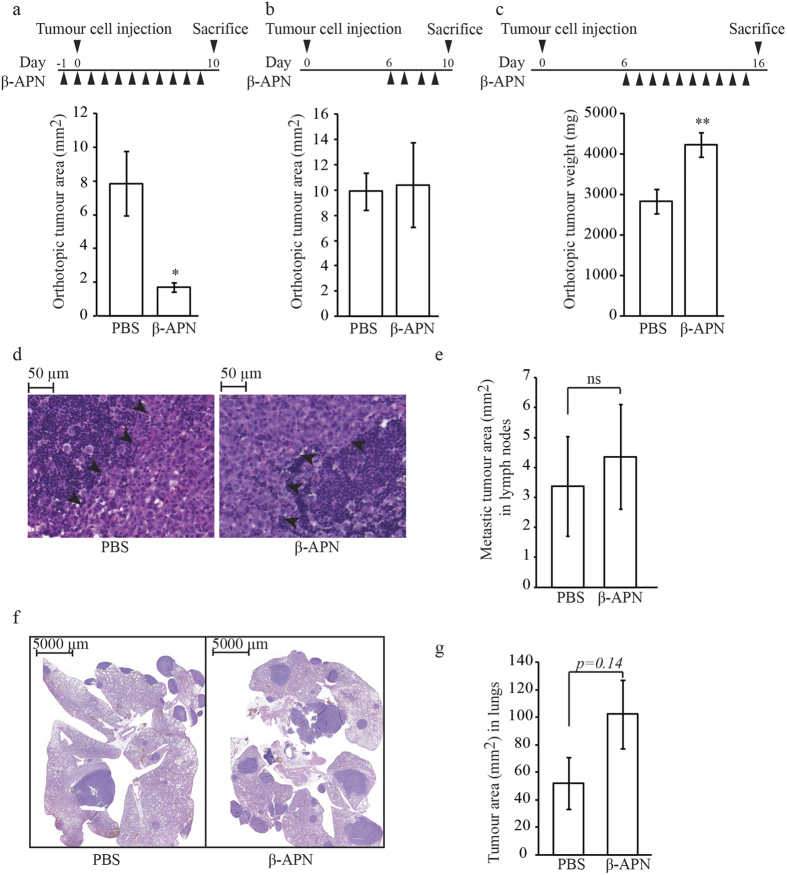
BAPN treatment of rat prostate tumours.Rats were injected orthotopically with AT-1 prostate tumour cells (2 × 103 cells) and treated with an inhibitor of LOX-family enzymes (BAPN, 100 mg/kg) or vehicle (PBS) and tumour weight was analyzed in three different experiments: (a) treatment was started one day before tumour cell implantation and continued on a daily basis until sacrifice at day 10; (b) treatment was started on day 6 when tumours were established, and continued on a daily basis until sacrifice at day 10; and (c) treatment started on day 6 and continued on a daily basis until sacrifice at day 16. Values are mean tumour area (mm2) or mean tumour weight (mg) at sacrifice ± SEM; n = 6–8 per group; *p < 0.05, **p < 0.01. (d) Representative haematoxylin- and eosin-stained sections showing tumour growth in the lymph nodes of both PBS- and BAPN-treated animals (arrowheads indicate the border between lymph node tissue and tumour tissue). (e) Tumour area of spontaneous lymph node metastases in animals with orthotopic tumours treated with BAPN or PBS from day 6 to day 16. Values are mean ± SEM; n = 5 per group; ns: not significant (f) Representative haematoxylin- and eosin-stained sections showing tumour growth in the lungs of both PBS- and BAPN-treated animals. (g) Lung tumour burden in animals injected intravenously with AT-1 cells and treated with a LOX inhibitor (BAPN, 100 mg/kg) or vehicle (PBS) from day 6 to day 16. Values are mean ± SEM; n = 7 per group.